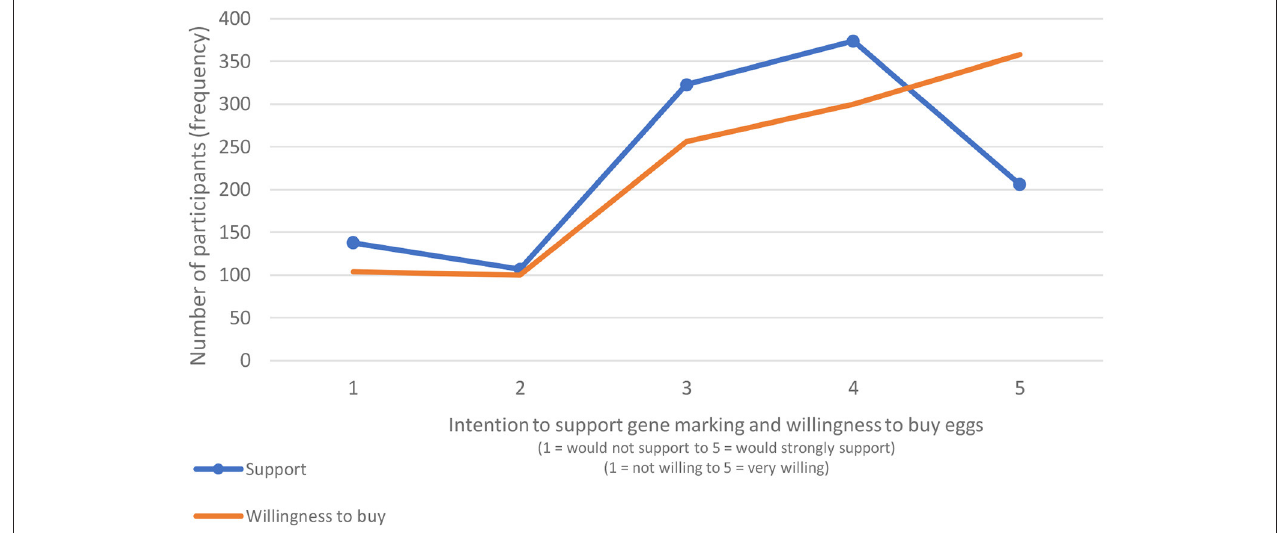
FIGURE 4 | Frequencies for the two dependent variables: support and willingness to purchase eggs ( N =